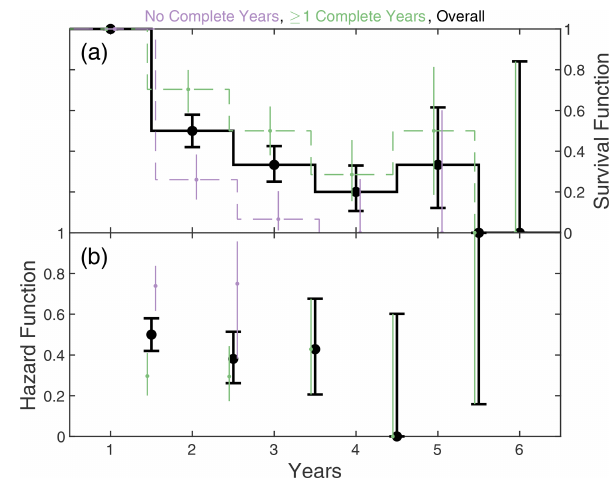
Figure 5. Schools’ survival (a) and hazard (b) functions across years in a similar format to Fig. 4. Overall results in black, with colours subdividing by schools which did (green) and did not (pur- ple) complete at least 1